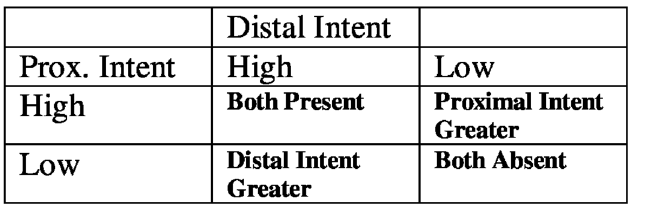
Fig 1. A representation of proximal and distal intent as independent